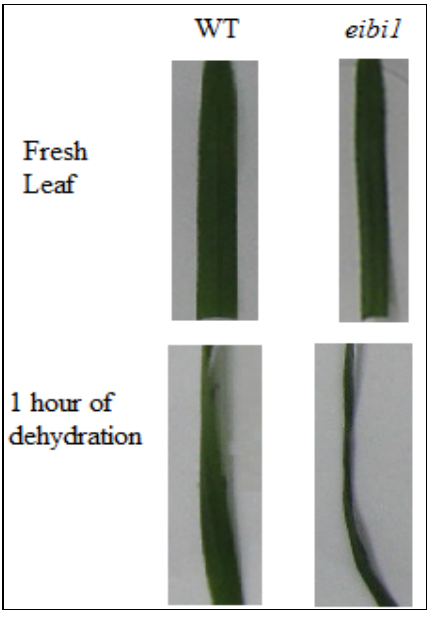
Figure 3. Phenotypes of leaves of eibi1 and wild type before or after